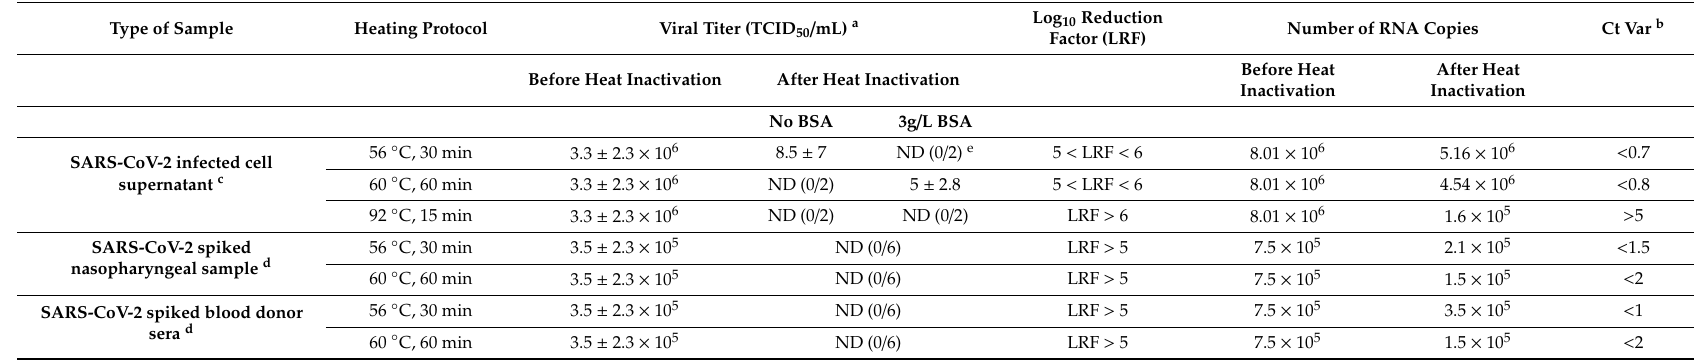
Table 1. Heat inactivation of three types of samples and impact on the RNA